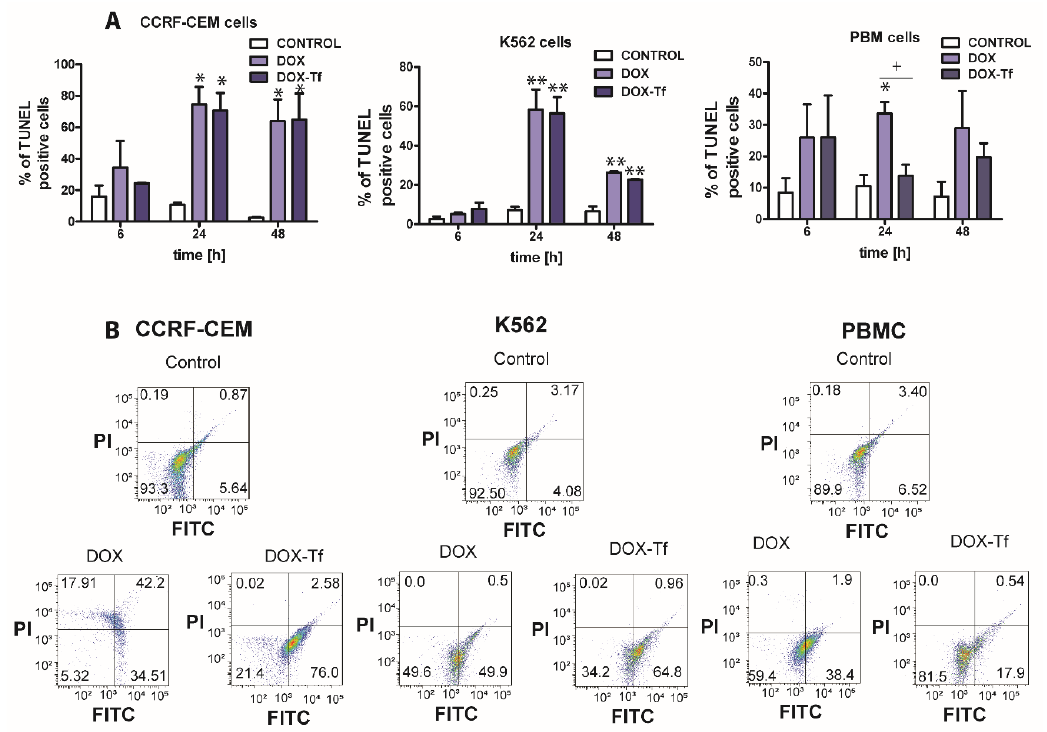
Figure 3. DNA damage is correlated with doxorubicin–transferrin-induced apoptosis in CCRF-CEM and K562 cell lines and in PBMCs ( A ) The influence free doxorubicin (DOX) and transferrin (Tf)-bound DOX (IC 50 concentrations, respectively) on the induction of apoptosis in human leukemia cells as well as normal PBMCs was determined by transferase dUTP nick end labeling (TUNEL) assay. Quantitative results, calculated as the level of TUNEL-positive cells, are presented as mean ± SD ( ≥ 3). * p < 0.05, ** p < 0.01 relative to the control (untreated cells); + p < 0.05 indicates statistically significant di ff erence between cells treated with DOX or DOX–Tf. ( B ) Typical cytometric dot-blots obtained after 24 h of incubation of human cancer and normal cells with IC 50 concentrations of DOX alone or DOX–Tf conjugate. Lower left down corner, TUNEL-negative cells, propidium iodide (PI)-negative; lower right corner, TUNEL-positive cells, PI-negative; left upper corner, TUNEL-negative, PI-positive cells; upper right corner, TUNEL-positive, PI-positive